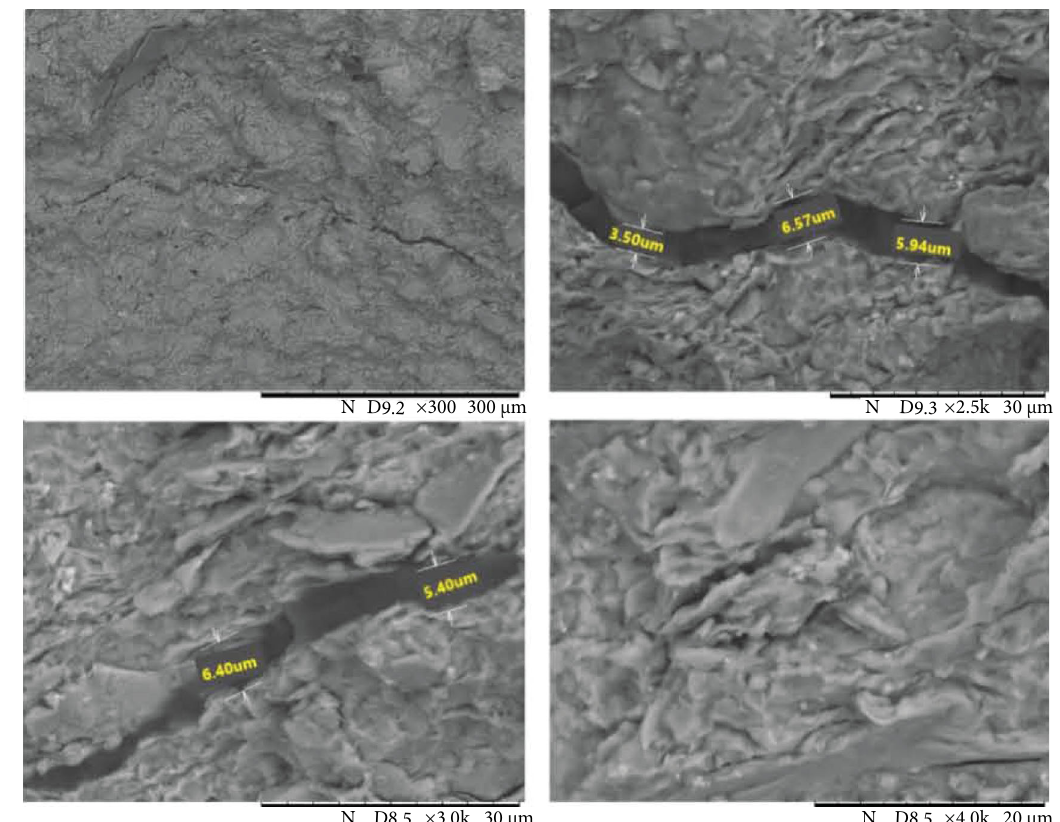
Figure 3: SEM analysis of internal structure of the middle-deep transition shale